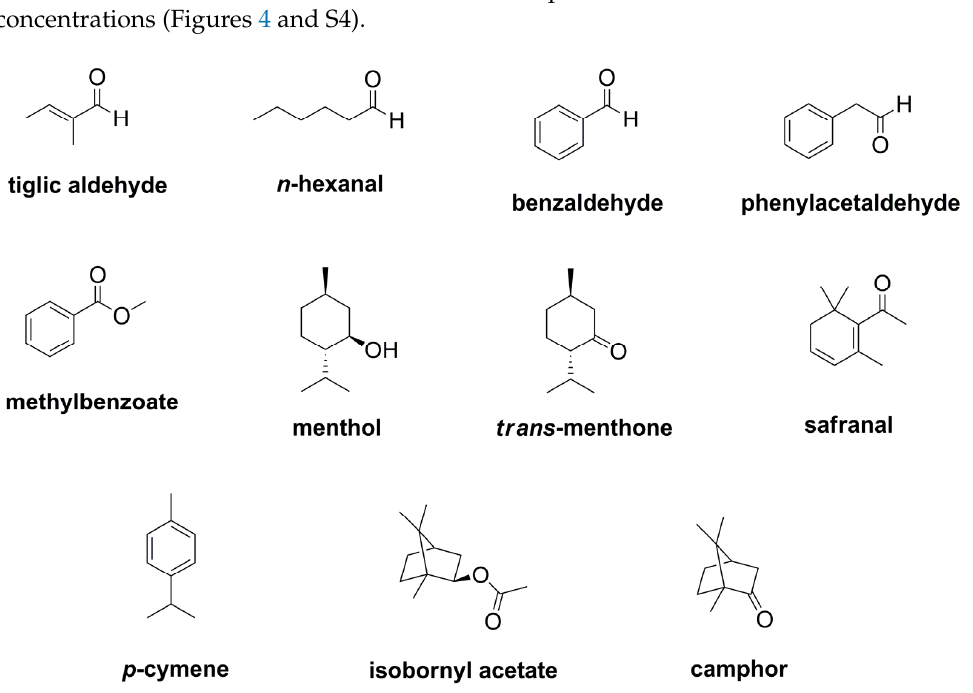
Figure 4. Chemical structures of quantified volatiles in blue fenugreek herb.